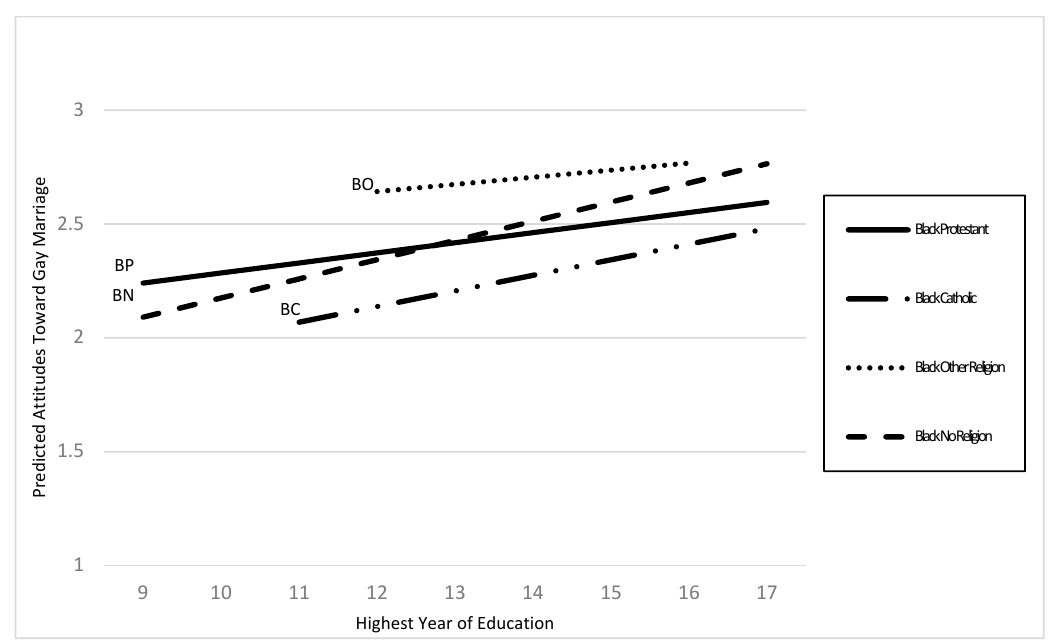
Figure 4. The interaction of religion and education on views on gay marriage.